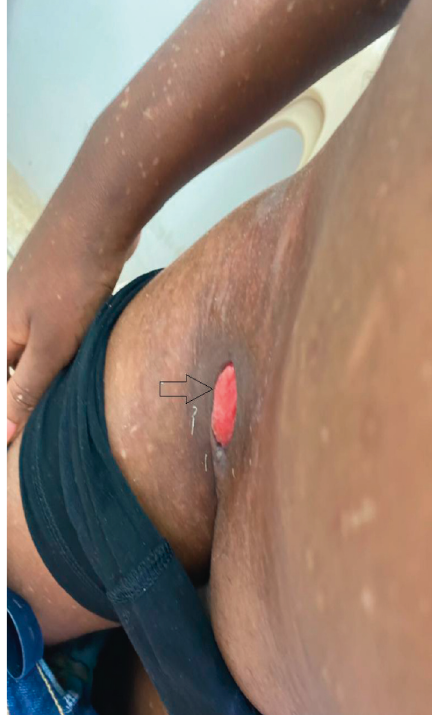
Figure 1: Vasculitic ulcer occurring at the groin. Multiple hypopigmented macules on the anterior abdominal wall, extensor surface of the right upper limb, and